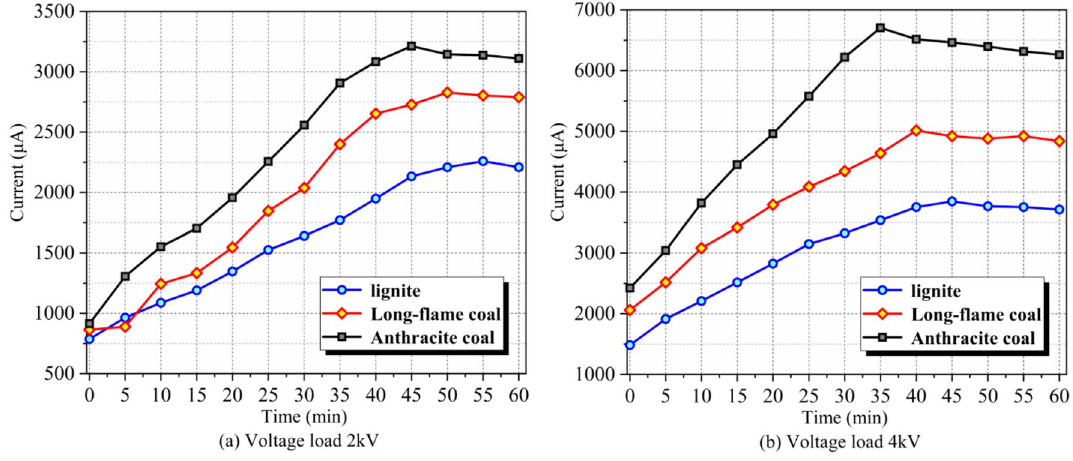
Figure 3. I–t curves of different coal